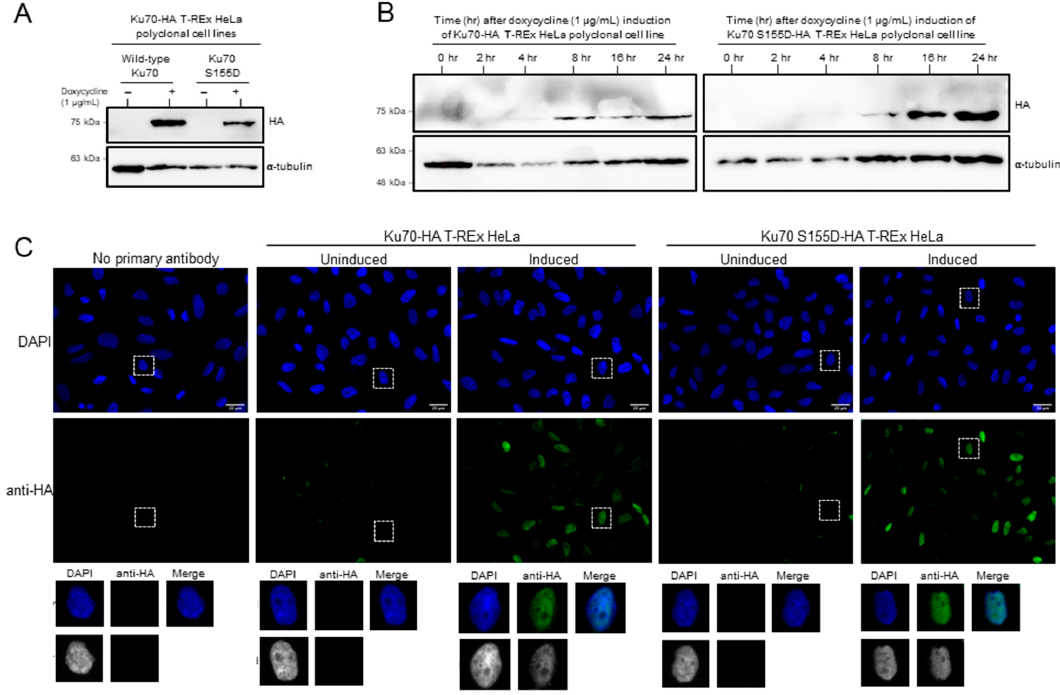
Figure 3. Generating doxycycline-inducible wild-type Ku70-HA and Ku70 S155D-HA Flp-In TM T-REx HeLa stable cell lines. All Western blots depicted show 50 µ g of whole cell extracts (WCE), with or without doxycycline (1 µ g/mL). Western blots were probed with HA and α -tubulin antibodies: ( A ) Western blot of inducible stable cell lines with and without 24 h of doxycycline; ( B ) time course experiment showing the inducible expression of both polyclonal stable cell lines induced with doxycycline over a period of 24 h; ( C ) cell lines induced with or without doxycycline for 24 h before analysis by indirect immunofluorescence using HA antibody, imaged at 647 nm wavelength. Images were taken at 40 × magnification with the white line representing 20 µ m. Representative images are shown with cropped enlargements of individual cells colored (top) or grey-scaled (below).